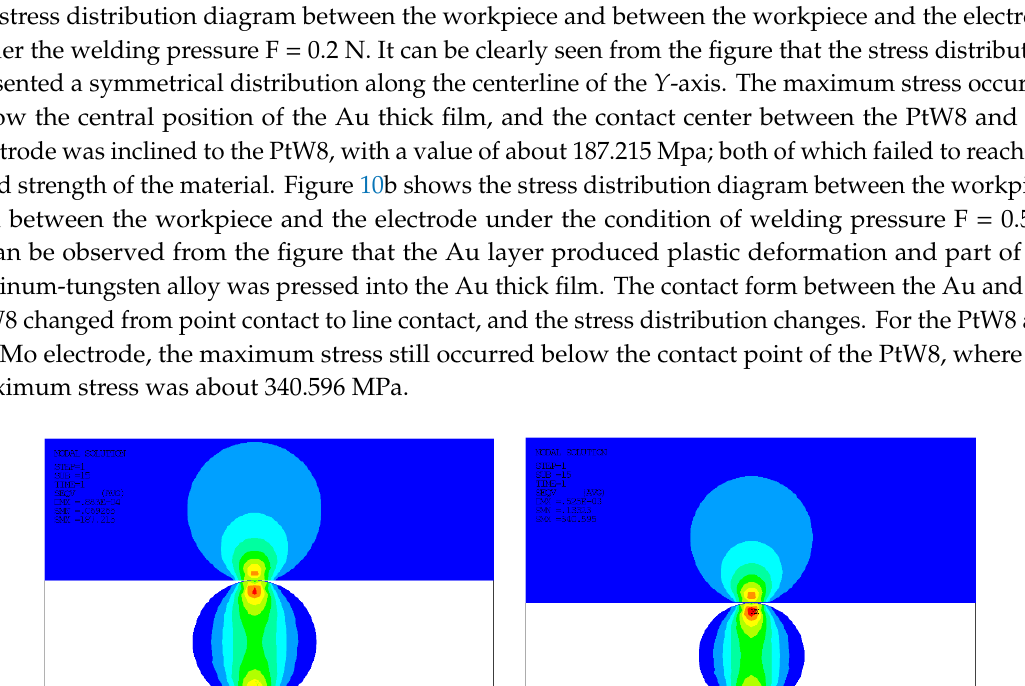
Figure 9. Finite element model of the preloading process.